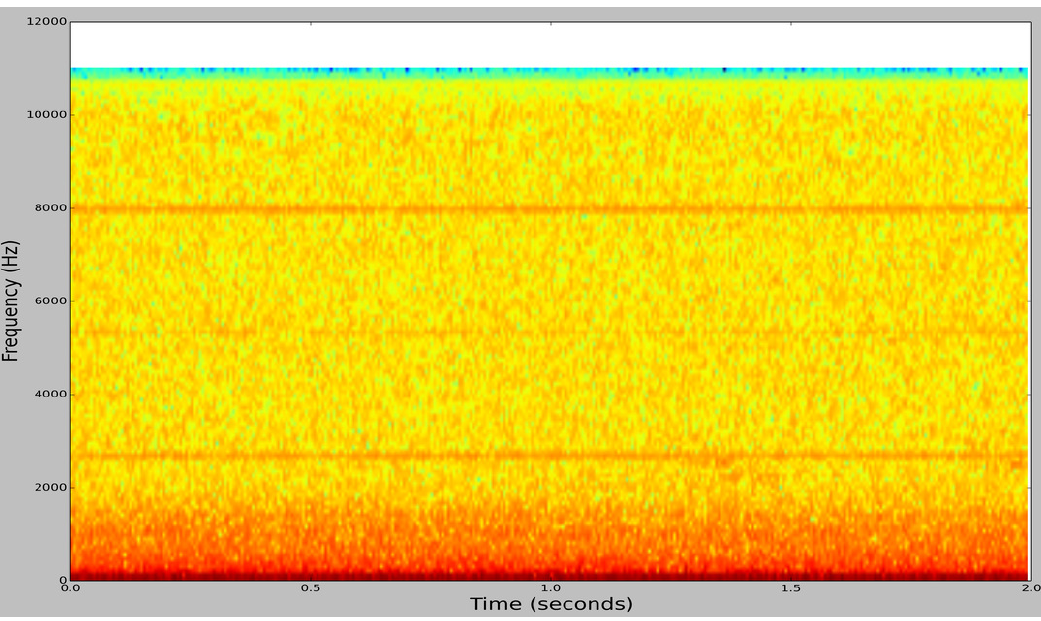
Figure 4. Spectrogram image of an ambient noise audio sample from